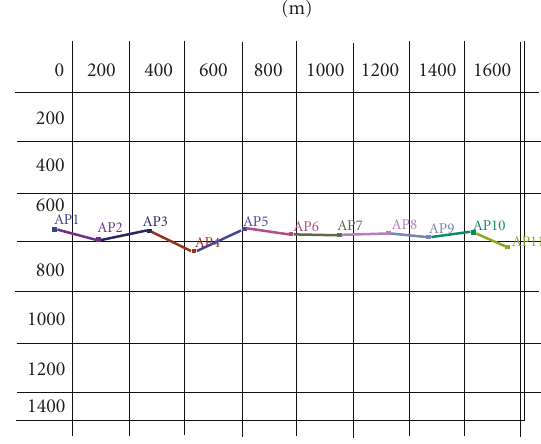
Figure 20: Topology for evaluating video tra ffi c